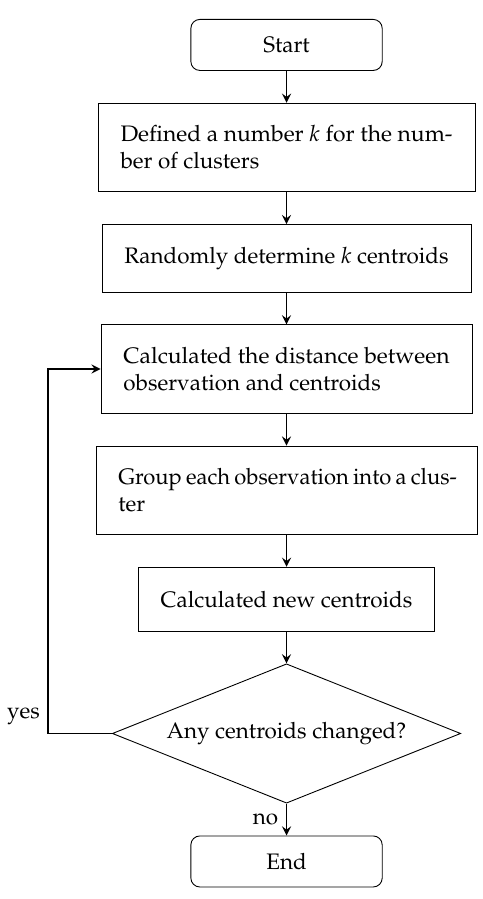
Figure 14. K-means clustering flow